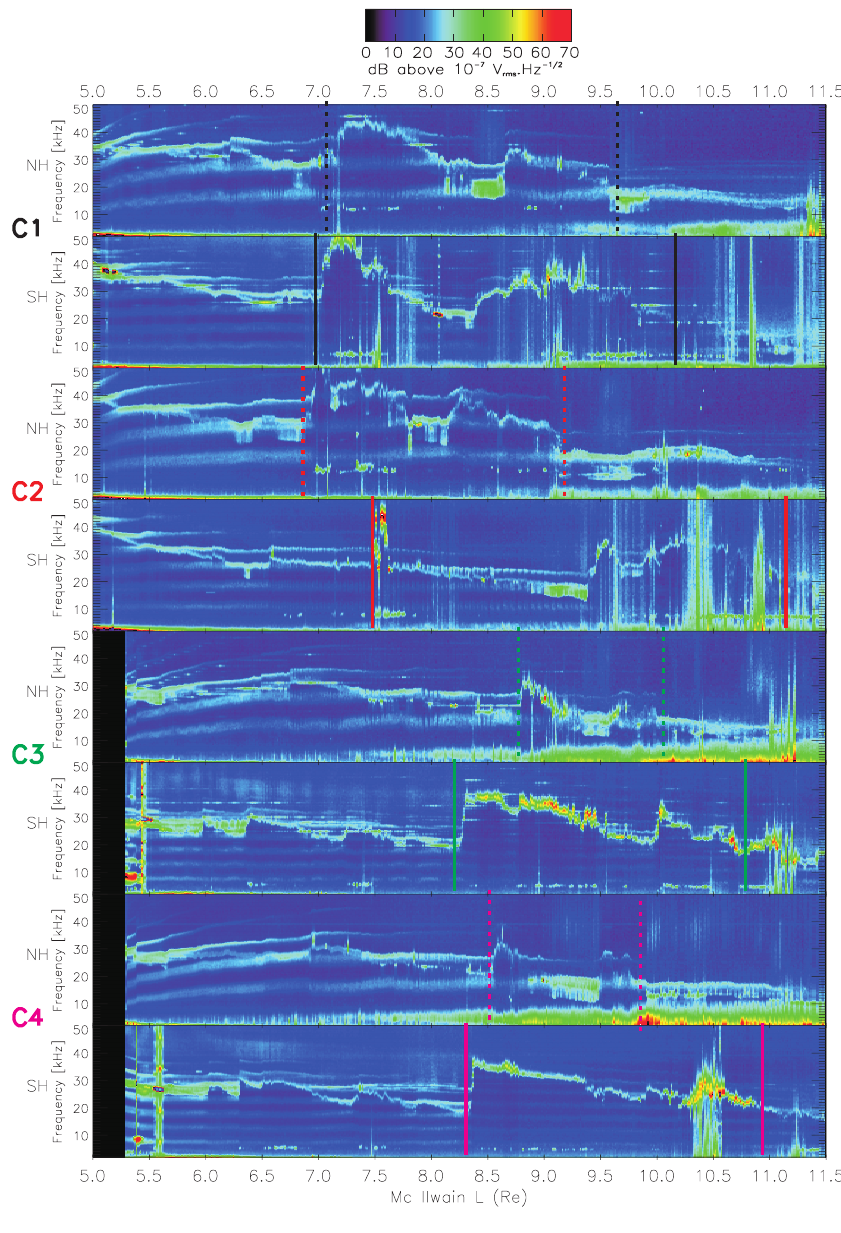
Fig. 6. Electric field spectrograms measured on 18 July 2005 by the WHISPER instruments as a function of the McIlwain L parameter onboard the four Cluster spacecraft. The figure is divided into a Northern Hemisphere (NH) panel and a Southern Hemisphere (SH) panel for each satellite. Colored lines delimit the plume crossings for each satellite, with full lines for SH and dotted lines for NH.